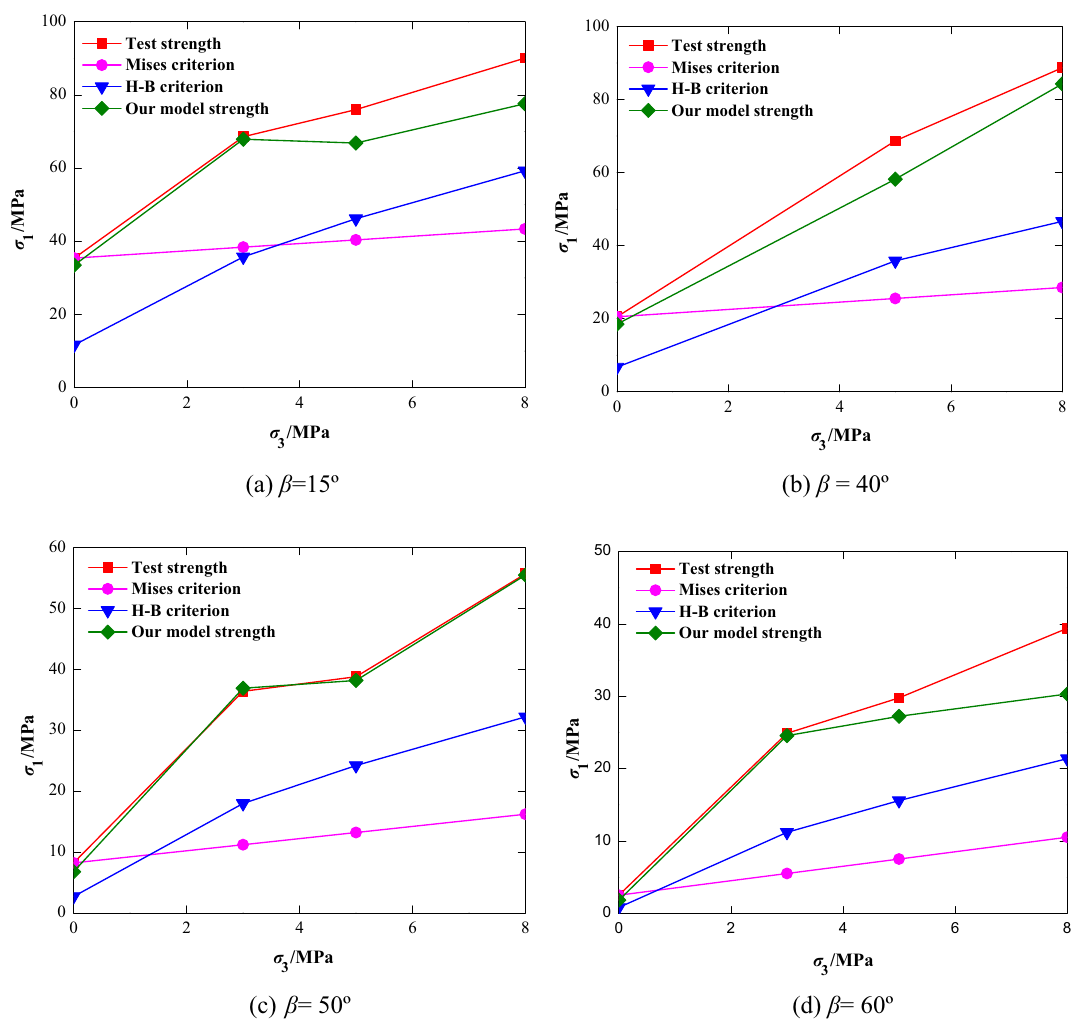
Figure 9. Comparison of strength curves of rock mass with different joint dip